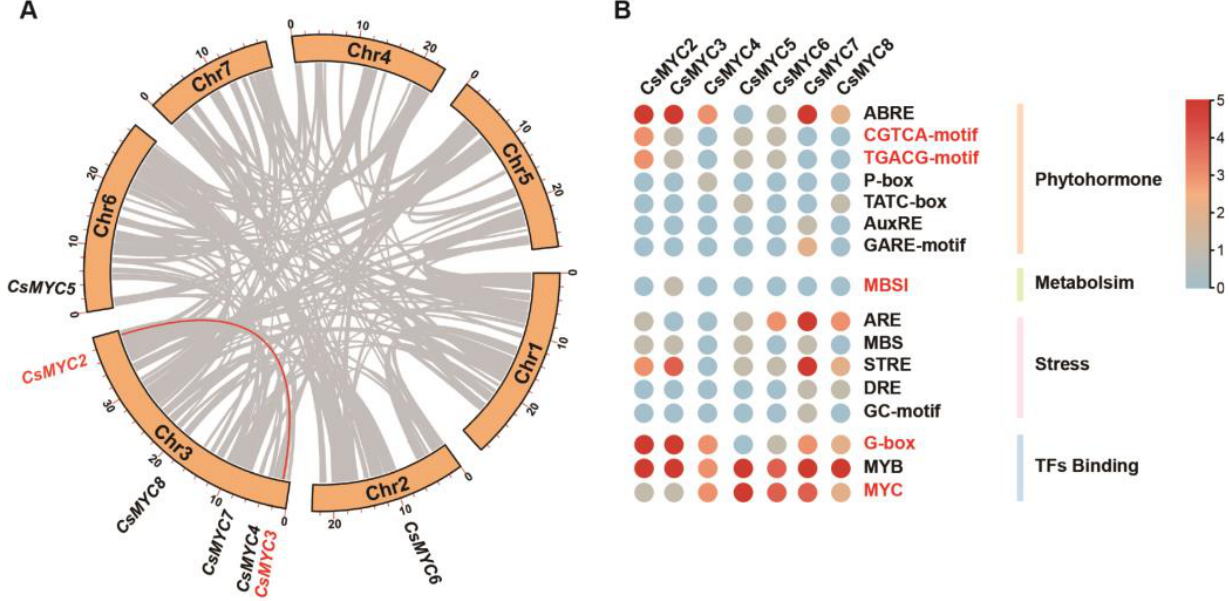
Figure 3. ( A ) Collinearity analysis of CsMYC2-CsMYC8 in cucumber. Grey lines show all gene duplications of the cucumber genome. Red lines show the duplicated genes in 7 candidates. ( B ) The cis -acting elements analysis of CsMYC2-CsMYC8 promoters. The numbers of cis -acting elements are shown in a heatmap.